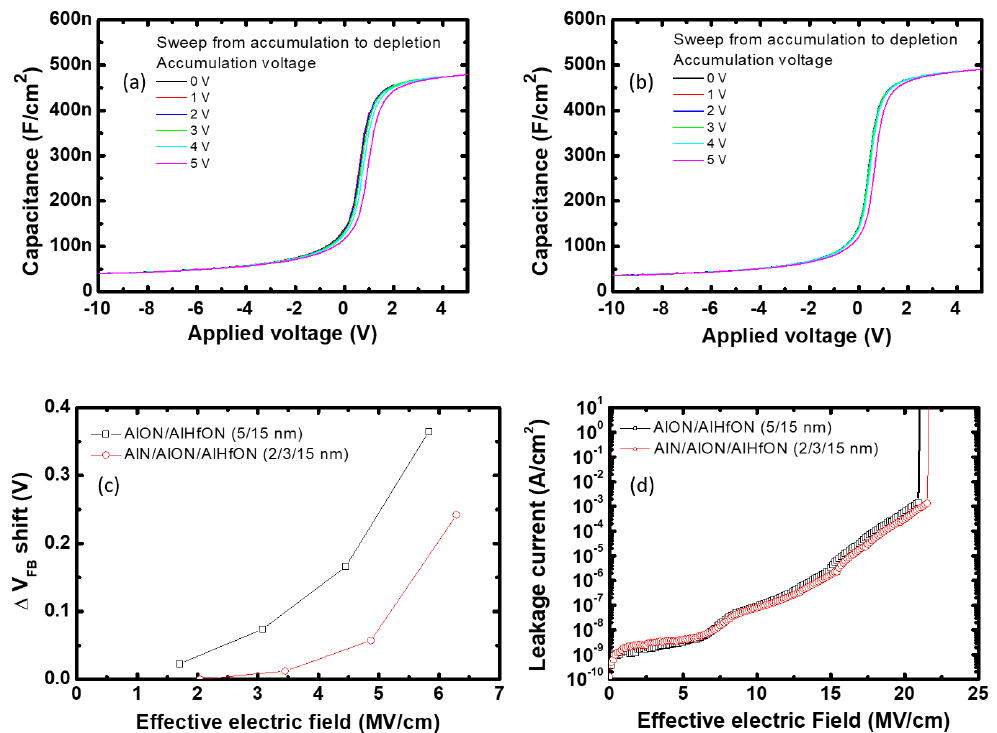
Figure 11. ( a , b ) C–V characteristics of the GaN MIS capacitors with accumulation voltages ranging from 0 V to 5 V; ( c ) V FB shift as a function of the effective electric field in the fabricated GaN MIS capacitors; and ( d ) J–E eff characteristics of the fabricated MIS capacitors (NH 3 plasma power: 30 W).